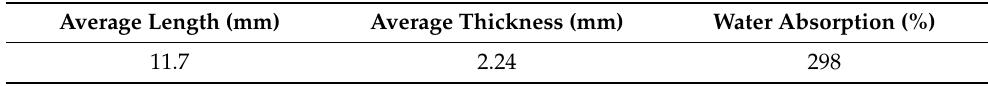
Table 2. Characteristics of hemp shiv.